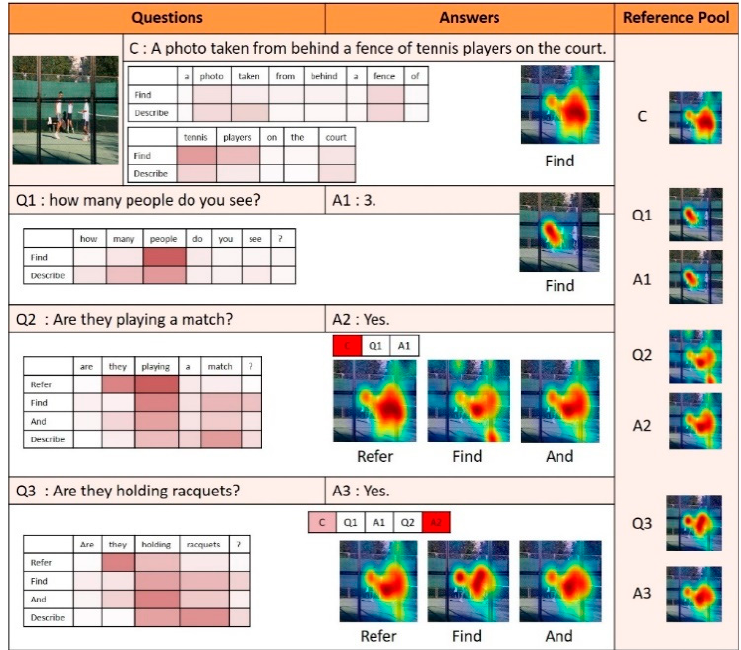
Figure 10. Dialog example 1 derived by the proposed model.